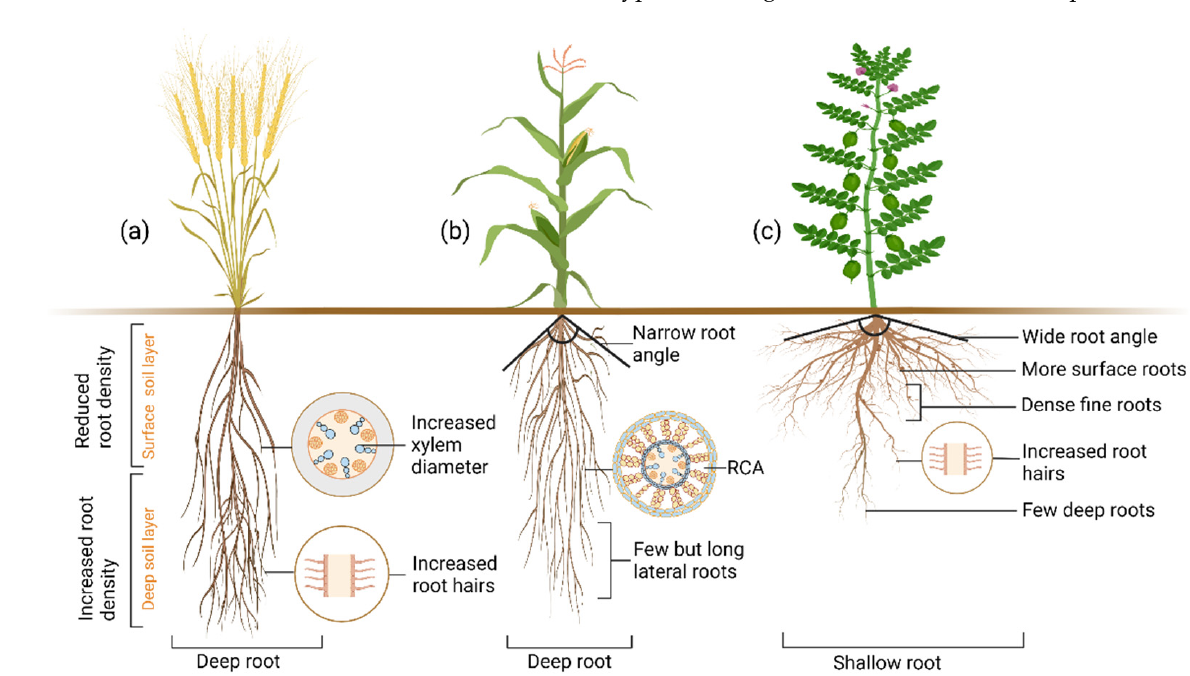
Figure 6. Different drought-adaptive root ideotypes. ( a ) Deep root, reduced root on soil surface layer, more root in the deep layer, and increased root hair and xylem diameter are crucial drought adaptation response traits ( b ) Deep root, narrow root angle, few but long lateral roots and more root cortical aerenchyma (RCA) are helpful for drought adaptation. ( c ) Shallow, wide-angle roots, more dense surface roots but few deep roots, and increased root hairs are the necessary root drought adaptation traits for low rainfall areas.